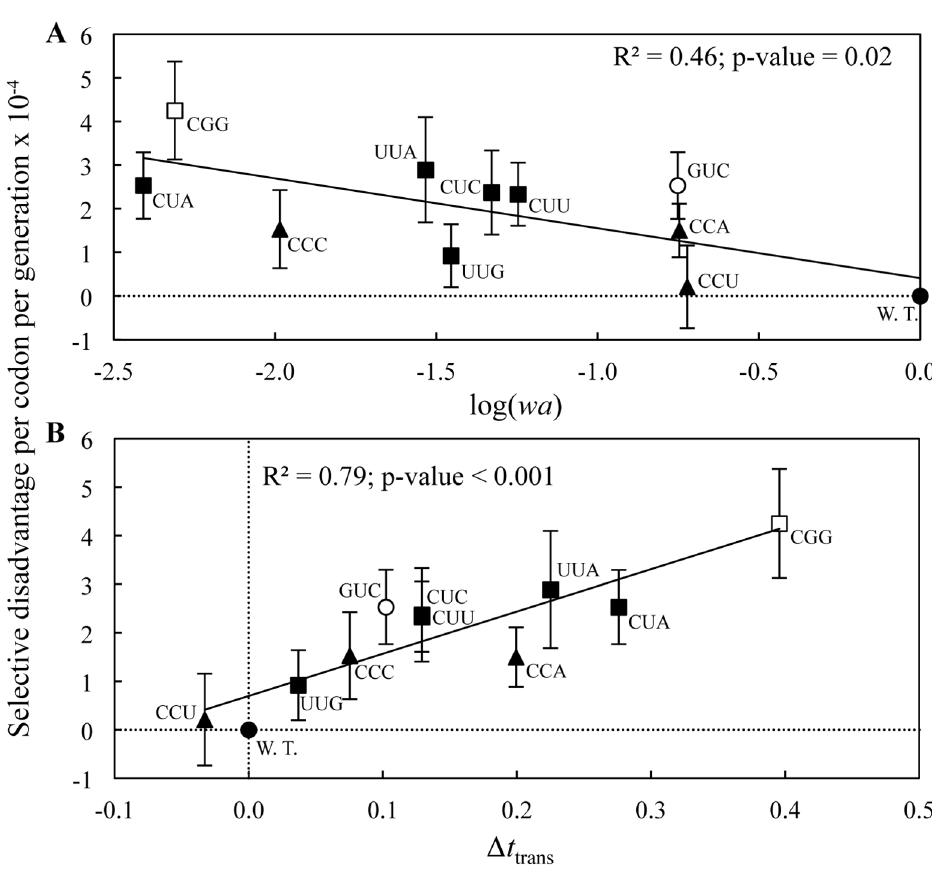
Fig 5. Selective disadvantage per codon per generation of synonymous tuf alleles. Selective disadvantage as a function of (A) logarithm of the relative adaptiveness and (B) increase in translational time for the tufA gene (filled circle) and synonymous tuf alleles with changes affecting codons for leucine (filled squares), proline (filled triangles), arginine (open squares), valine (open circles) and combinations of leucine and proline (filled diamonds). Results are shown as means ± 95% confidence interval. Codons are indicated next to the marker. Black line indicates regression